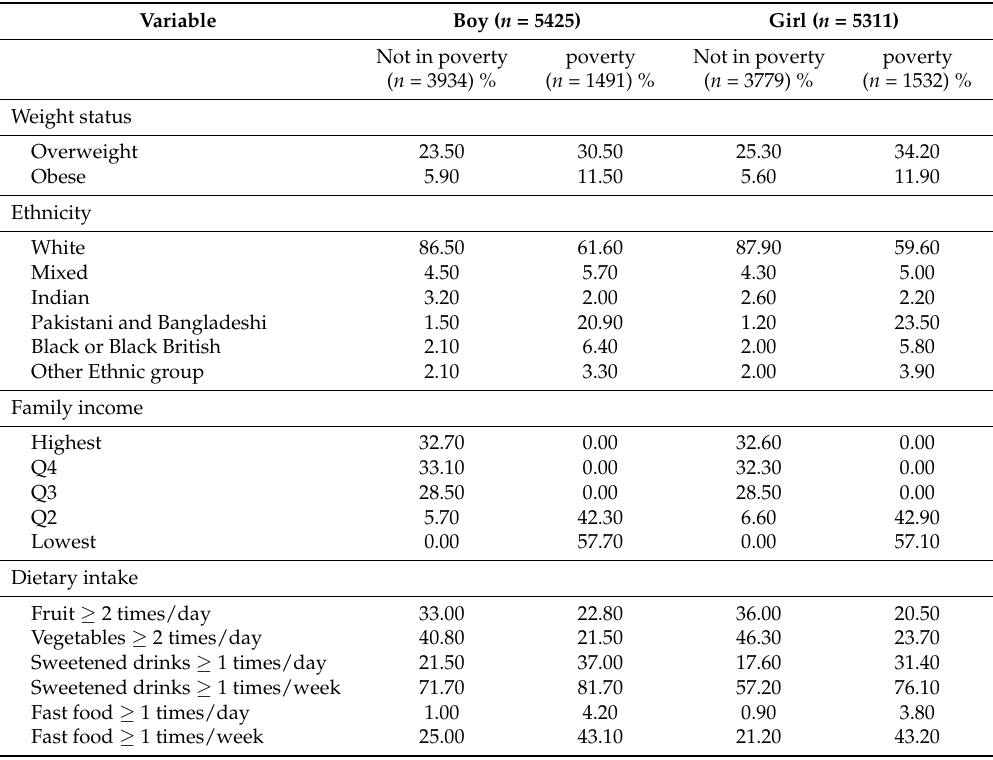
Table 1. Descriptive characteristics of sample ( n =